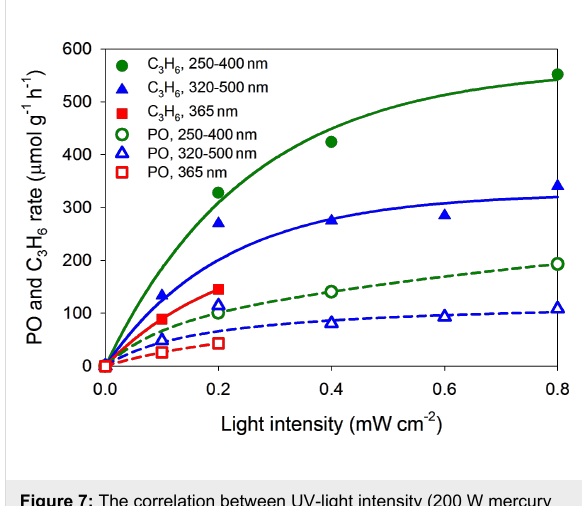
Figure 7: The correlation between UV-light intensity (200 W mercury arc lamp) and C 3 H 6 consumption rate and PO formation rate. Lines are presented for guiding and are not based on a kinetic